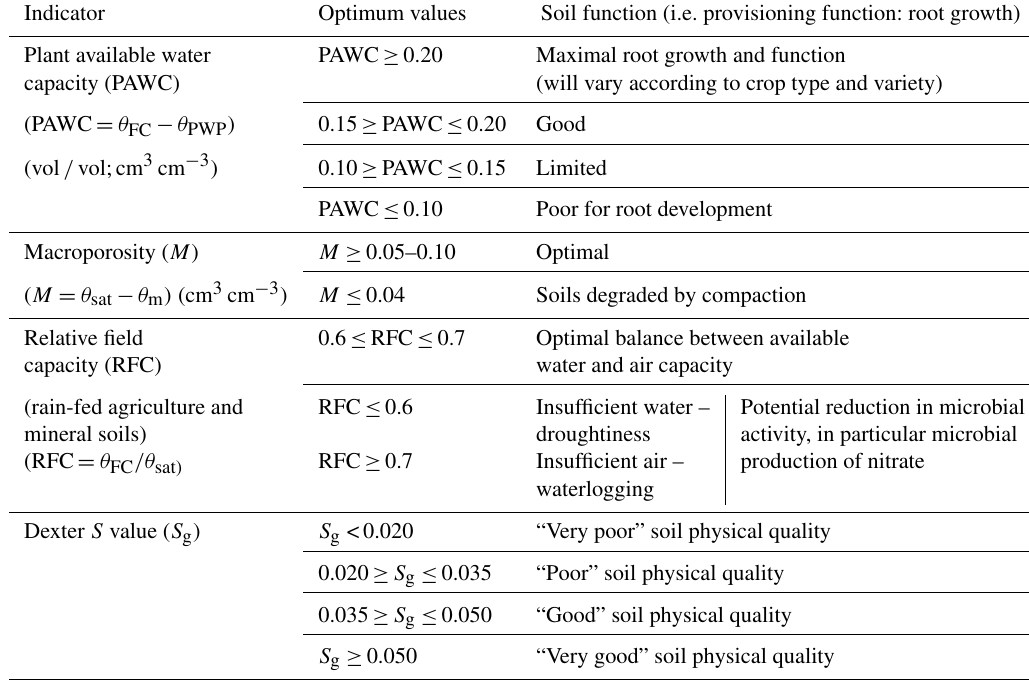
Table 2. Soil water retention characteristics indicators, optimum values and impacts on the provisioning soil function. Values for PAWC, M and RFC taken from Reynolds et al. (2009). Values for Dexter S value taken from (Dexter, 2004a). θ FC : volumetric moisture content at field capacity, occurring at 0.5 or 1m pressure head; θ sat : saturated moisture content at 0m pressure head; θ PWP : moisture content at permanent wilting point, occurring at 150m pressure head; θ m : porosity of the soil matrix occurring at 0.1m pressure head. Indicator Optimum values Soil function (i.e. provisioning function: root growth) PAWC ≥